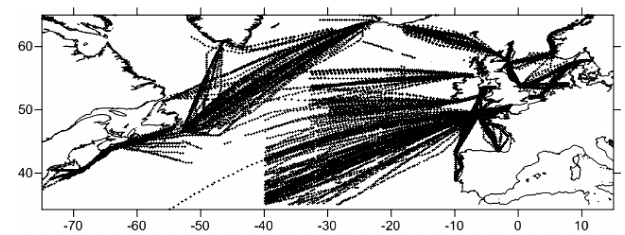
Figure 2. CPR data sampling routes, 2000–2009.